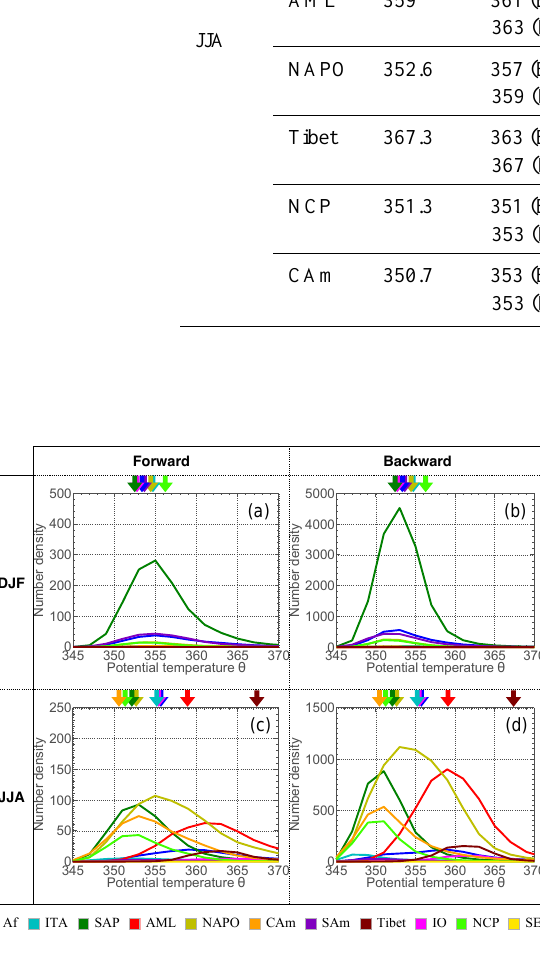
Figure 5. Same as Fig. 3 when the +1km altitude correction of the cloud tops is not